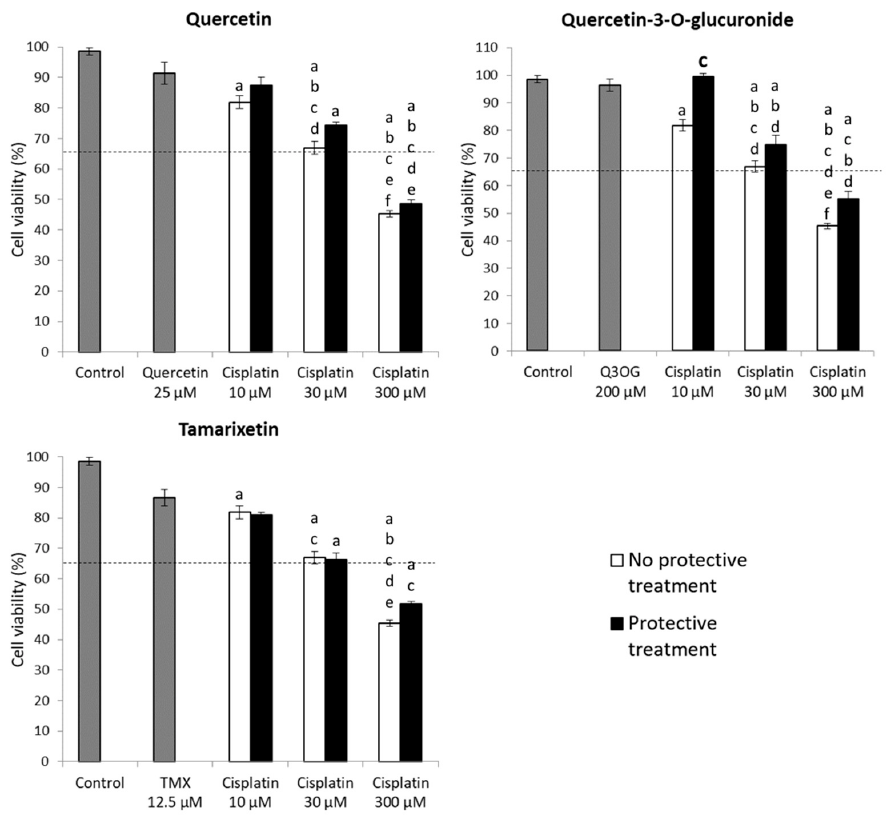
Figure 7. Quercetin, quercetin 3- O -glucuronide and tamarixetin efficacy assays in NRK-52E cells